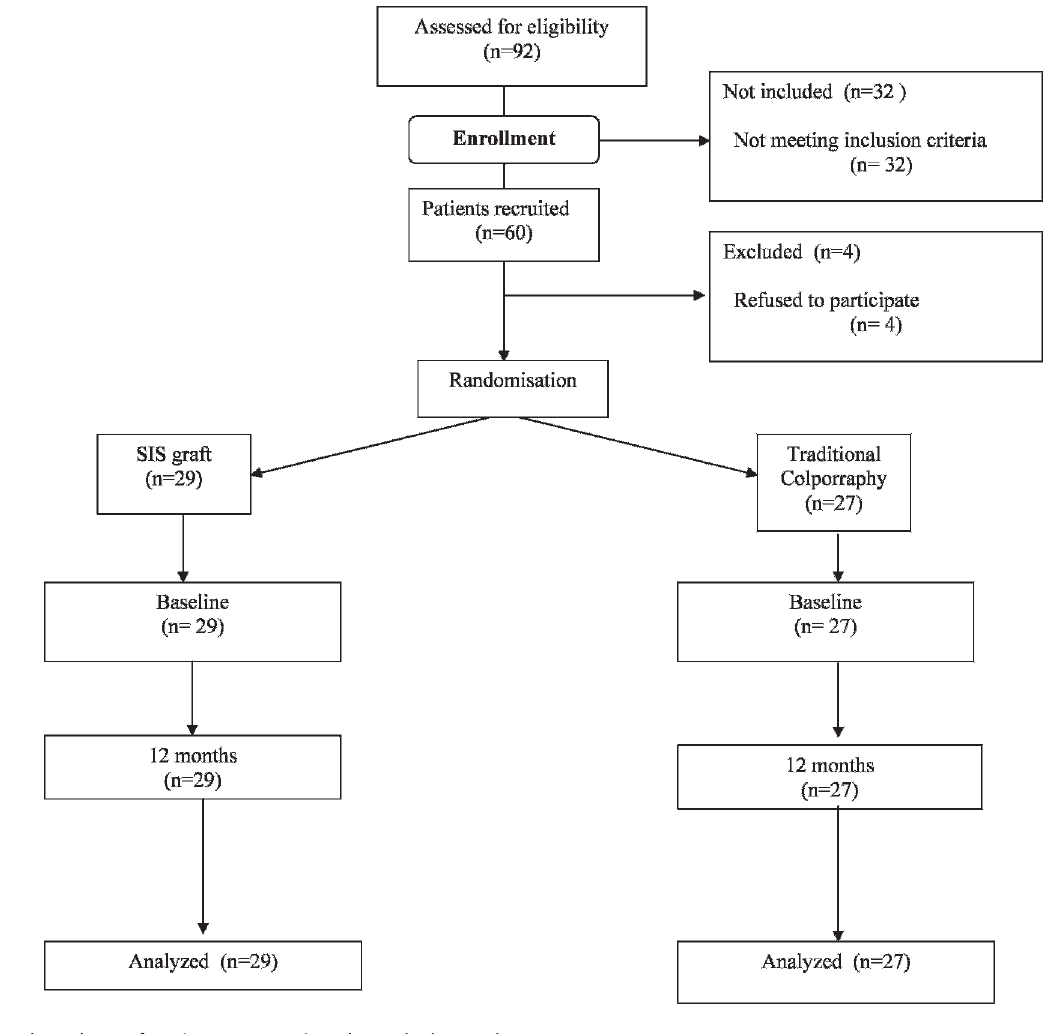
Figure 1 - Flow chart of patient progression through the study.